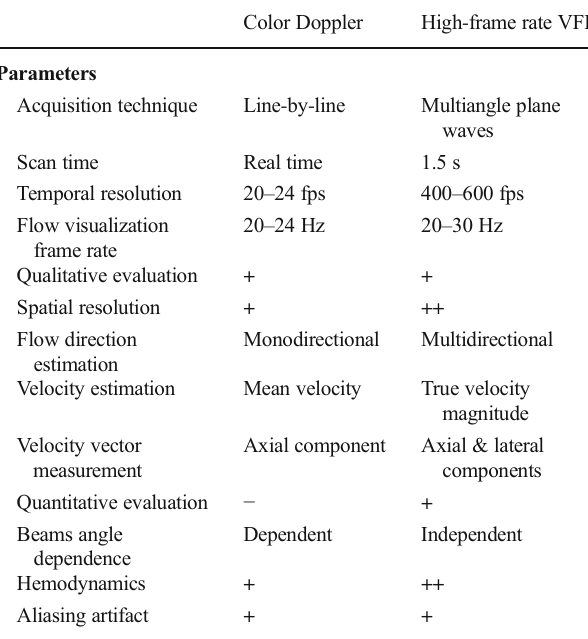
Comparison of technical characteristics between color Doppler and high-frame rate VFI Color Doppler High-frame rate